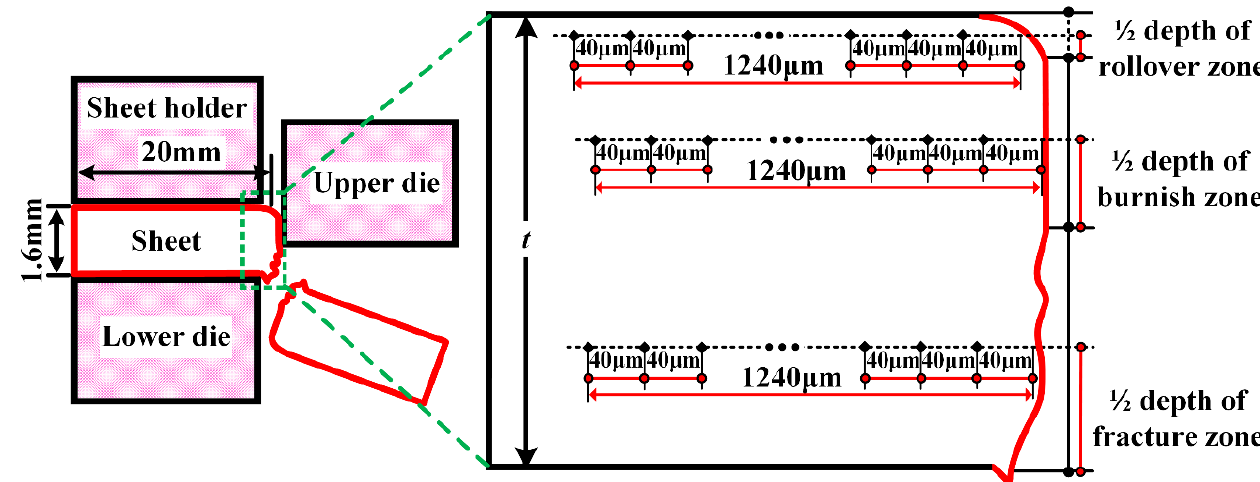
Figure 4. Location of microhardness testing points.